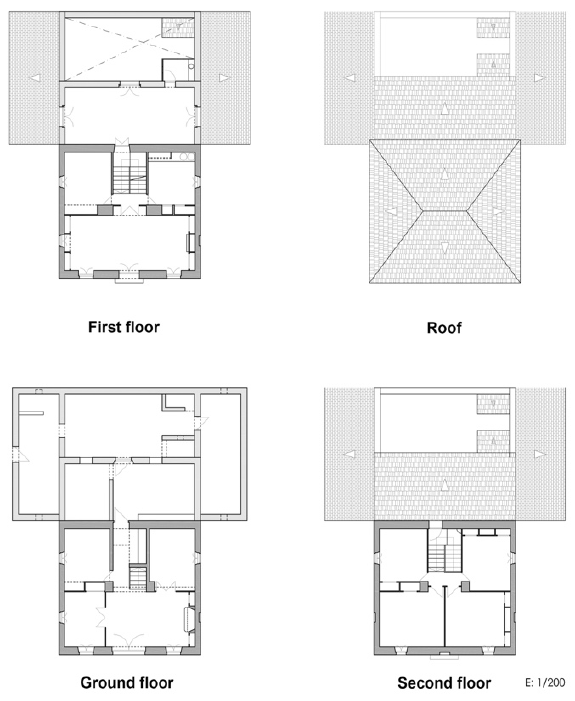
Figure 13. Casa de la Glorieta plan.